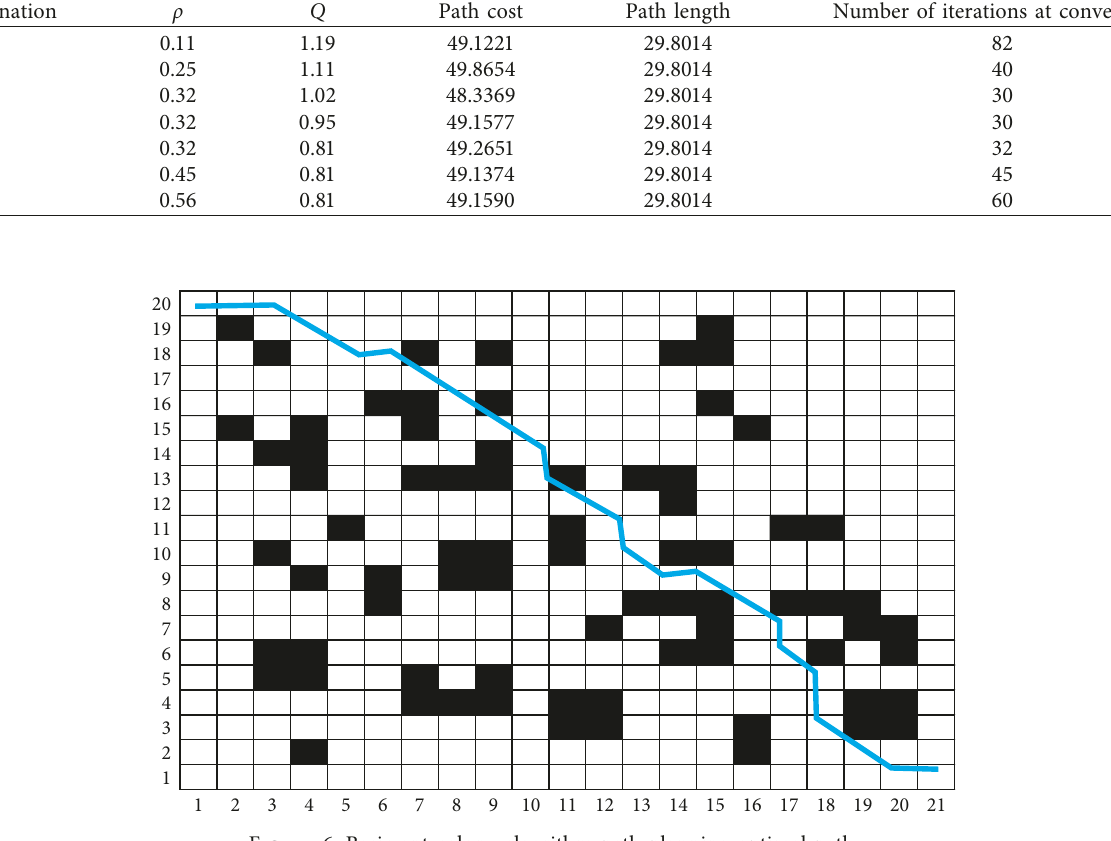
Table 5: Effects of different ρ and Q combinations on the basic ant colony algorithm.